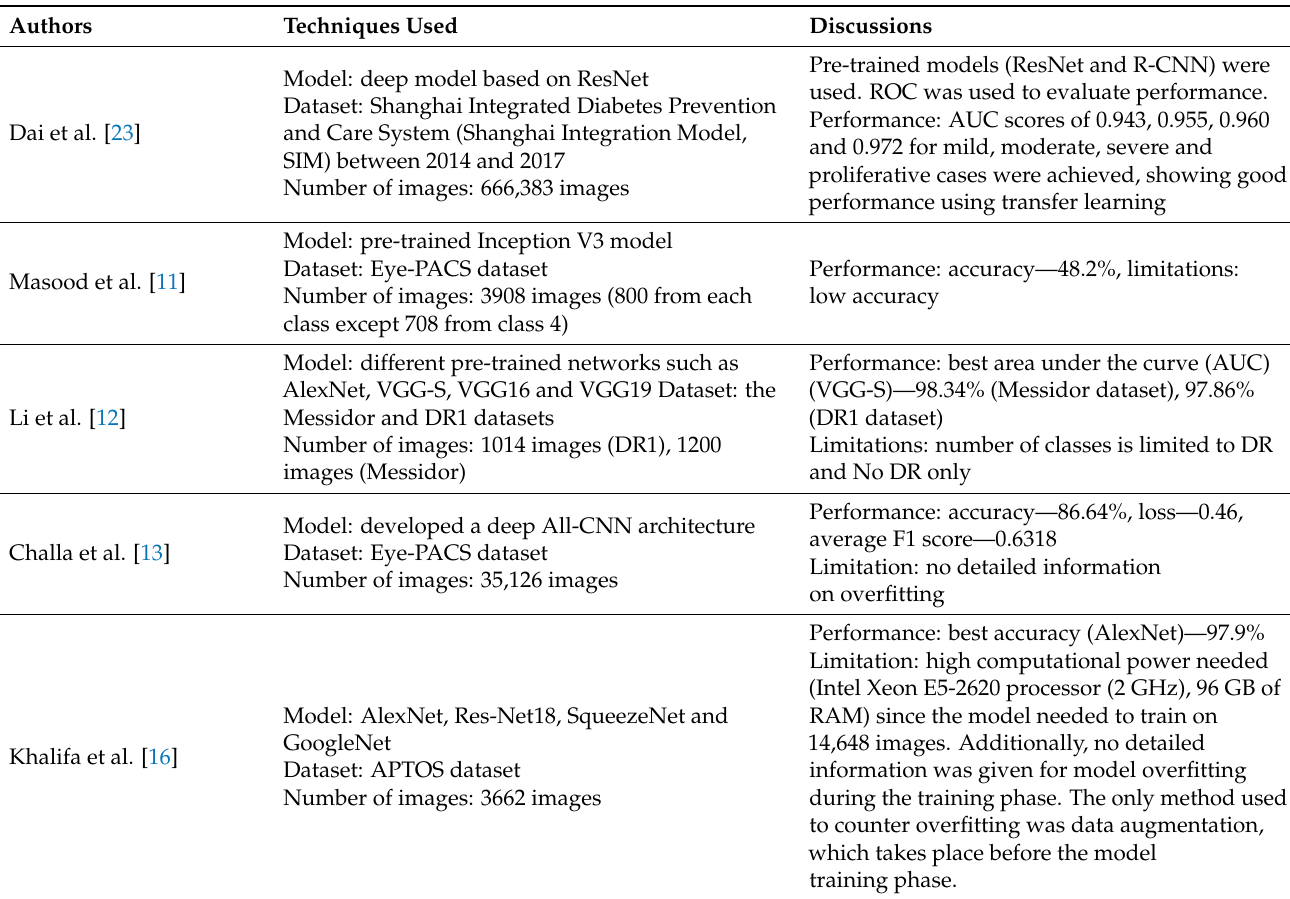
Table 3. Comparison table of similar